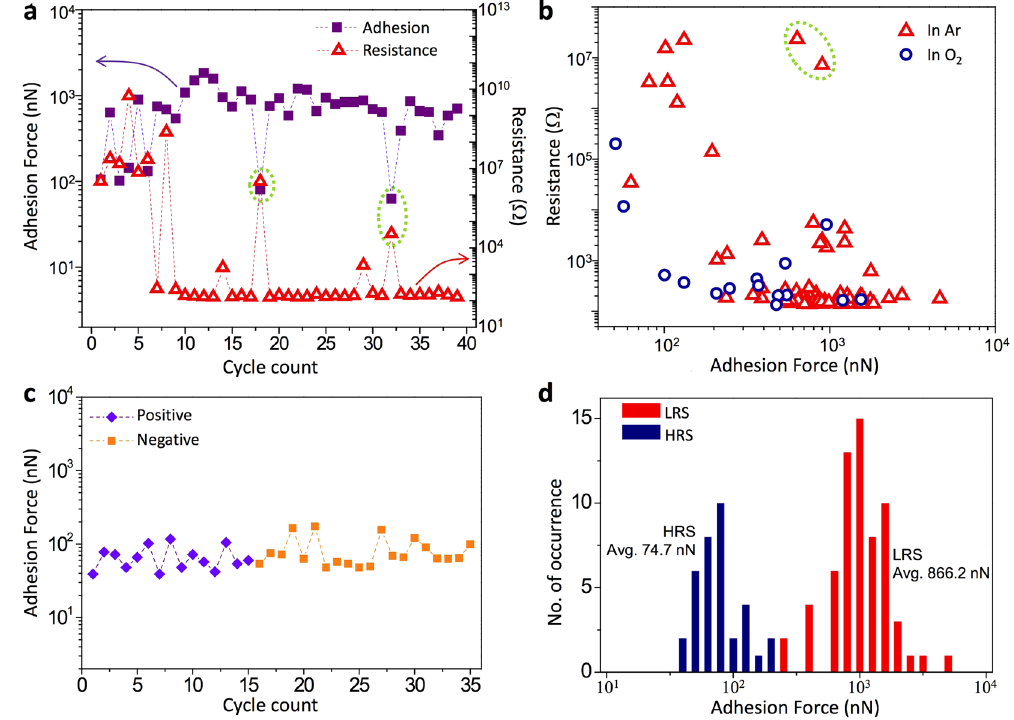
Figure 4. ( a ) The resistances of a Pt/TiO 2 /Pt cell and the corresponding adhesive forces at the active interface (i.e., the interface between the Pt/TiO 2 coated tip and the Pt substrate). Each set of the resistance and adhesive force is measured sequentially immediately after a set process with a compliance current of 20 μ A on a different tip location of Pt substrate. ( b ) Cell resistances and corresponding adhesive forces measured in dry Ar and O 2 environment. ( c ) Adhesive forces measured right after URS reset processes with positive sweeps (anodic substrate bias; number 1–15) and negative sweep (number 16–35). Numbers do not indicate the measurement sequence. The measured adhesive forces (~100 nN) were significantly lower than those of URS LRS cells (~1 μ N). ( d ) Distribution of measured adhesion forces after set and reset